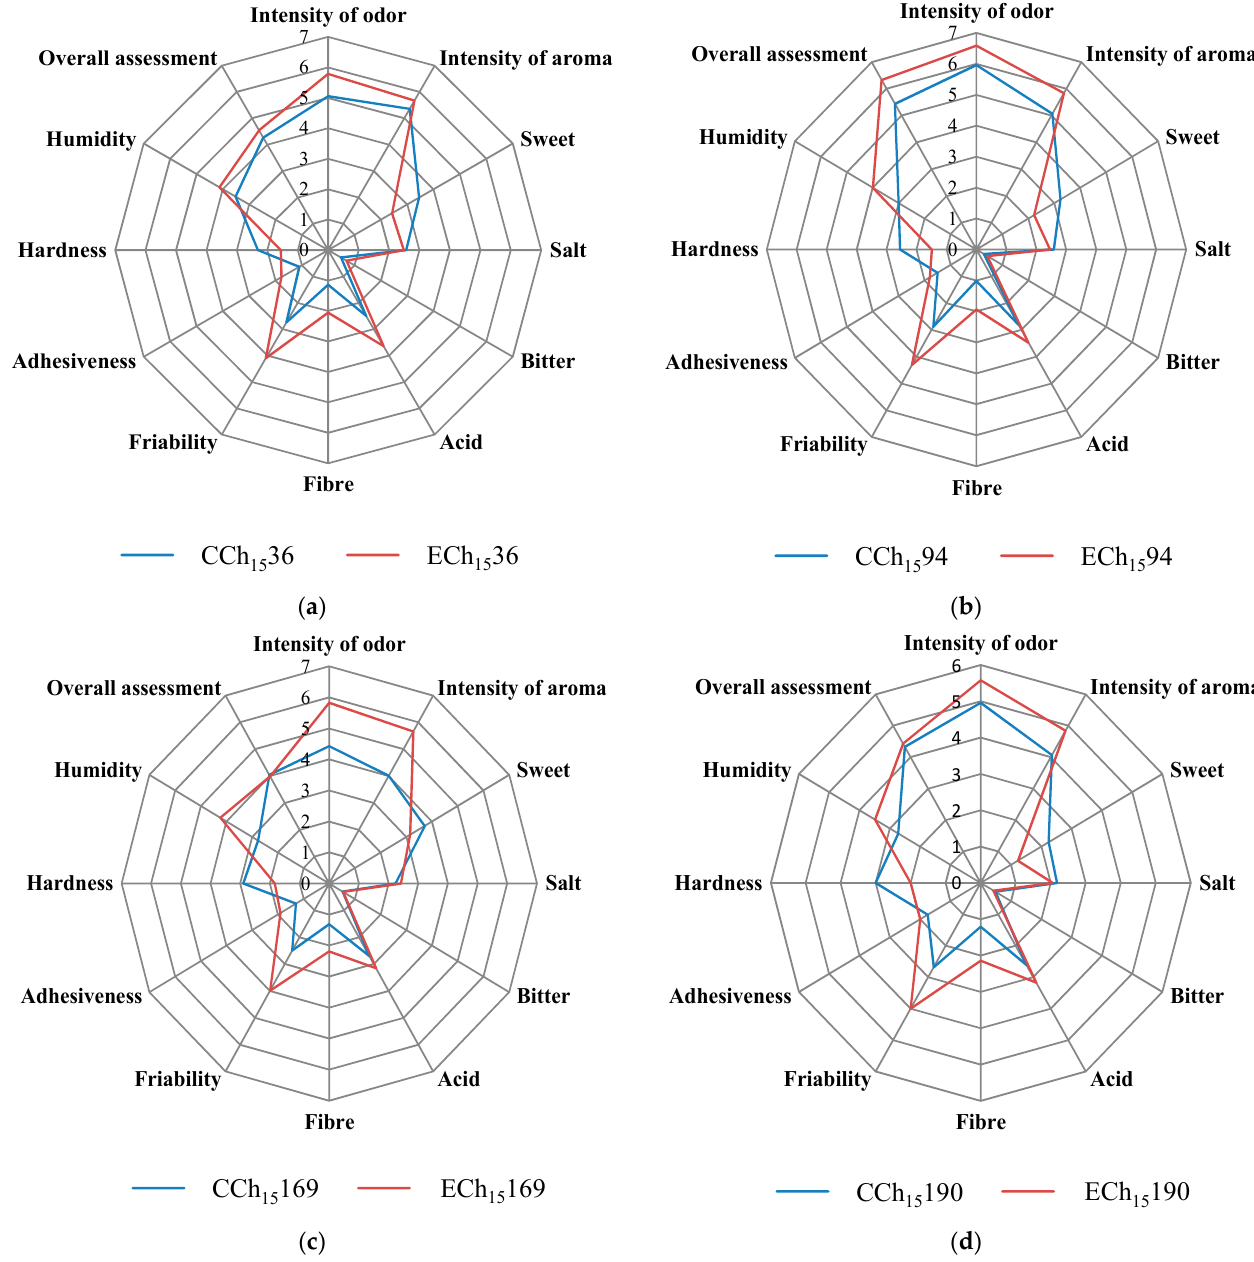
Figure 4. Spider diagrams corresponding to the descriptive sensory analysis of cheeses. ( a ) CCh 15 36, control cheese after 15 days of refrigerate storage with L. lactis MISE36; ECh 15 36, experimental cheese after 15 days of refrigerate storage with L. lactis MISE36 + 1% of GPP; ( b ) CCh 15 94, control cheese after 15 days of refrigerate storage with L. lactis MISE94; ECh 15 94, experimental cheese after 15 days of refrigerate storage with L. lactis MISE94 + 1% of GPP; ( c ) CCh 15 169, control cheese after 15 days of refrigerate storage with L. lactis MISE169; ECh 15 169, experimental cheese after 15 days of refrigerate storage with L. lactis MISE169+ 1% of GPP; ( d ) CCh 15 190, control cheese after 15 days of refrigerate storage with L. lactis MISE190; ECh 15 16, experimental cheese after 15 days of refrigerate storage with L. lactis MISE190+ 1% of GPP.